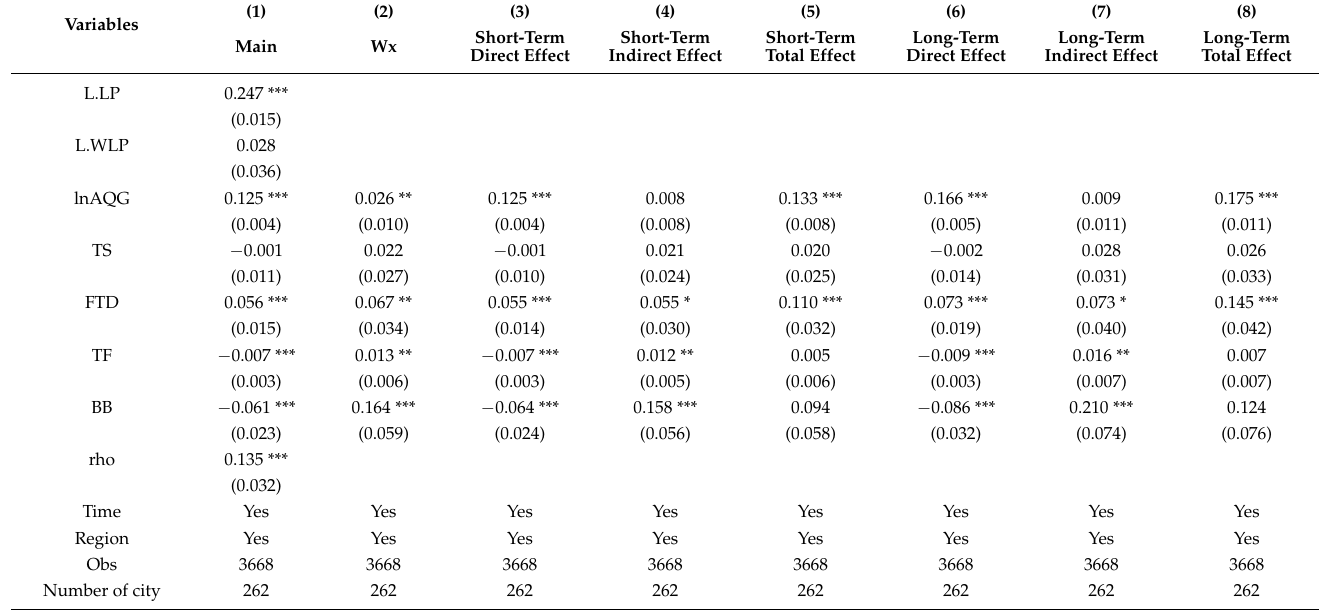
Table 14. Alternate regression method: the dynamic spatial Durbin model